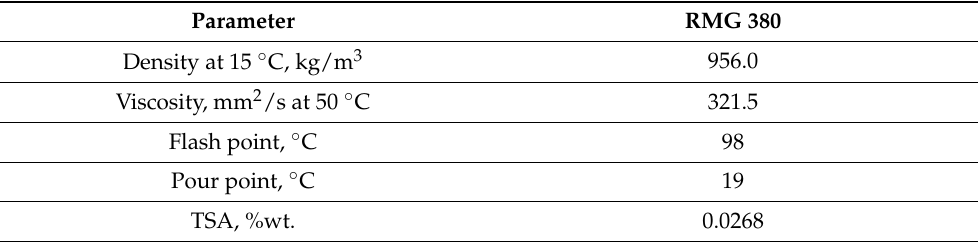
Table 4. The quality indicators of commercial residual marine fuel of RMG 380.